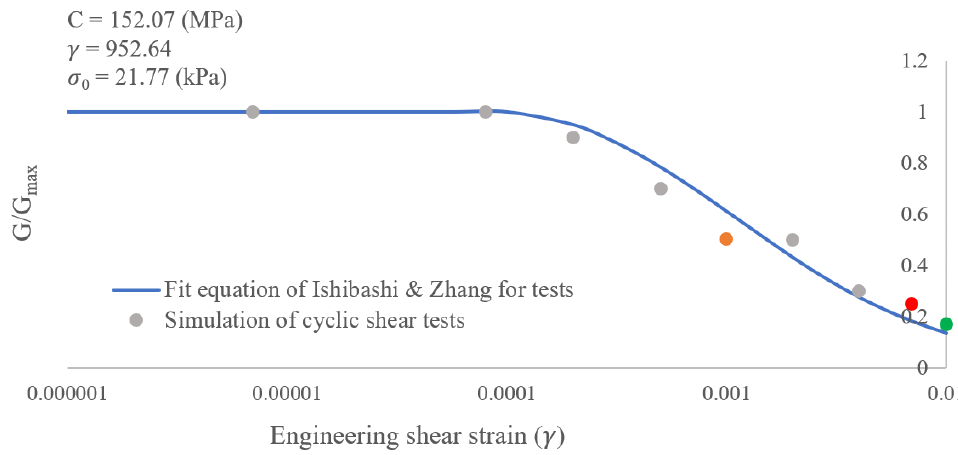
Figure 6. Comparison of an Finite Element-computed 𝑮 − 𝜸 curve with the experimental curve of Ishibashi and Zhang (1993).